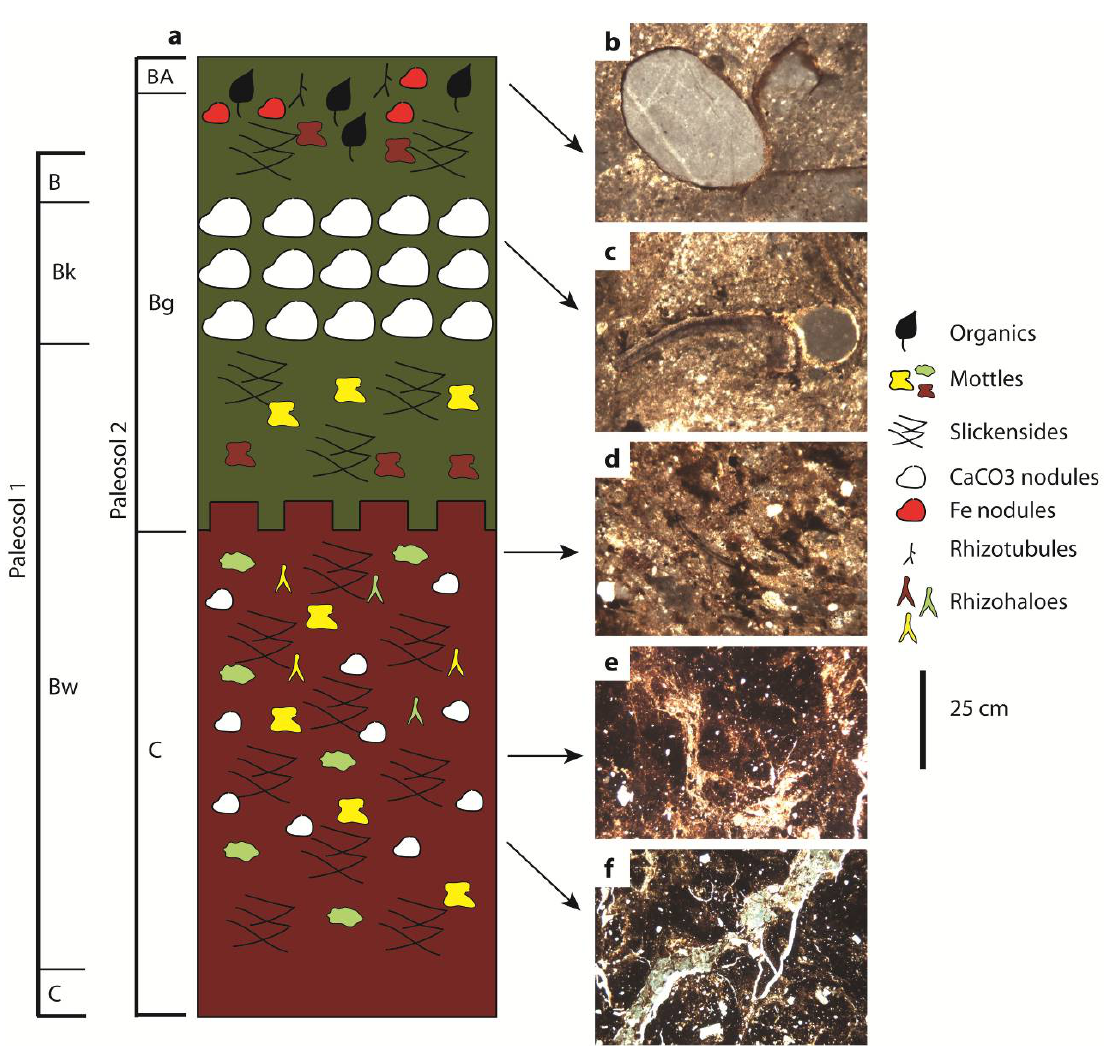
Figure 5. Detailed stratigraphic column and micromorphological features of the interpreted paleosols present in Section 3. ( a ) Detailed section of Units 1 and 2; ( b ) Carbonate nodule at 0–20 cm; ( c ) Carbonate nodule and shell fragment within carbonate horizon at 80–100 cm; ( d ) Illuviated clay surrounding fractures, 160–180 cm; ( e ) Porphyroskelic fabric, 220–240 cm; ( f ) Carbonate nodules within a fracture, 260–280